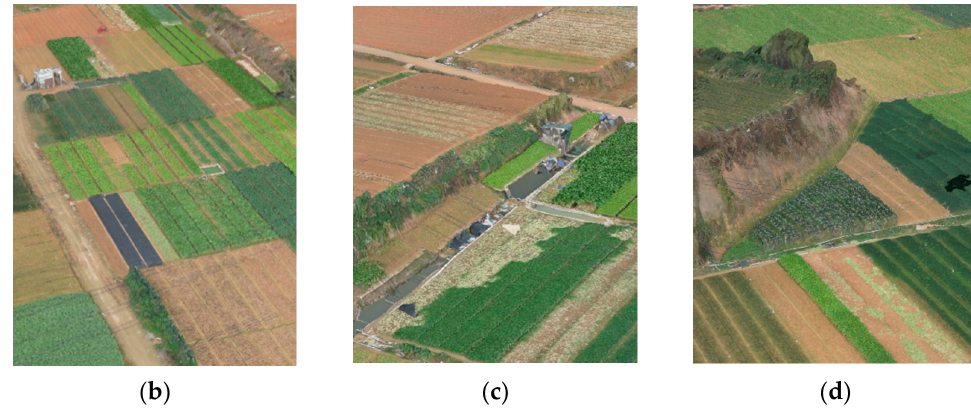
Figure A1. Terrain model reconstruction of the test site: ( a ) left part of the whole test site; and ( b , c , d ) detailed reconstruction models corresponding to 1, 2 and 3 labeled in ( a ).